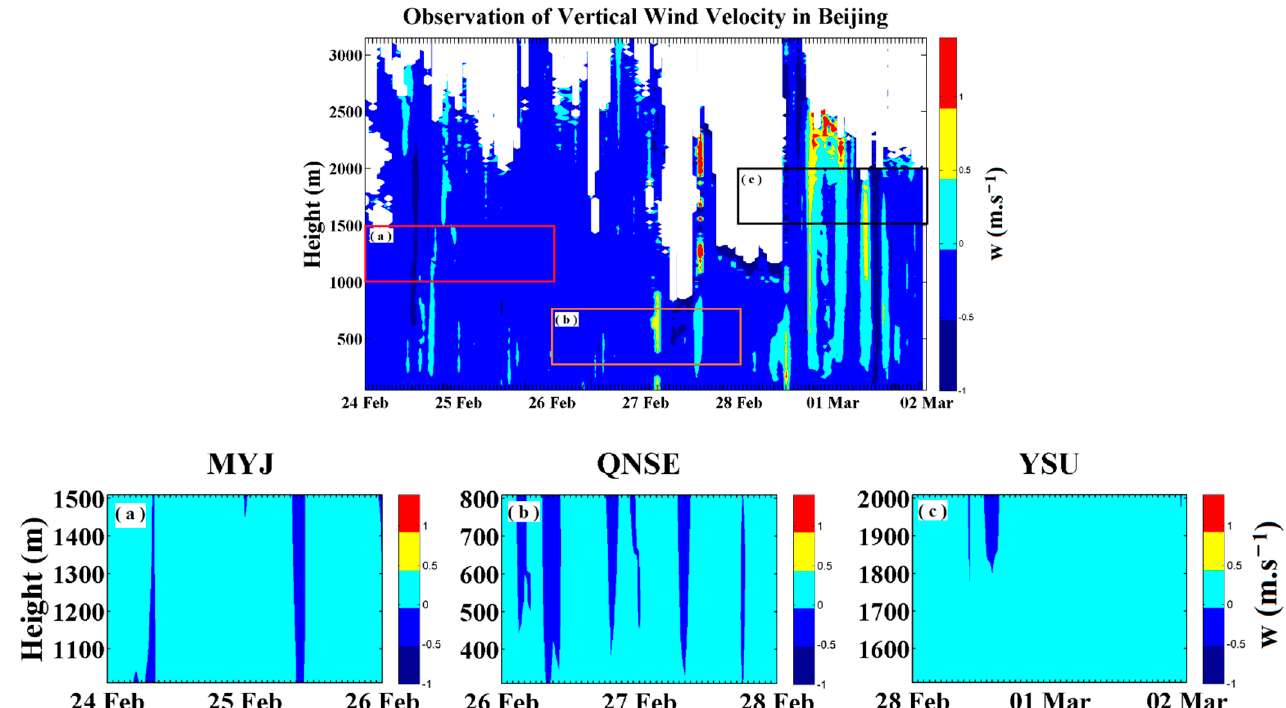
Figure 10. Comparison of vertical wind speeds between the observations and the simulations using ( a ) the GFS scheme at 1000–1500 m height on sunny days, ( b ) the MYNN3 scheme at 300–800 m height on hazy days, and ( c ) the UW scheme at 1500–2000 m height on windy days.